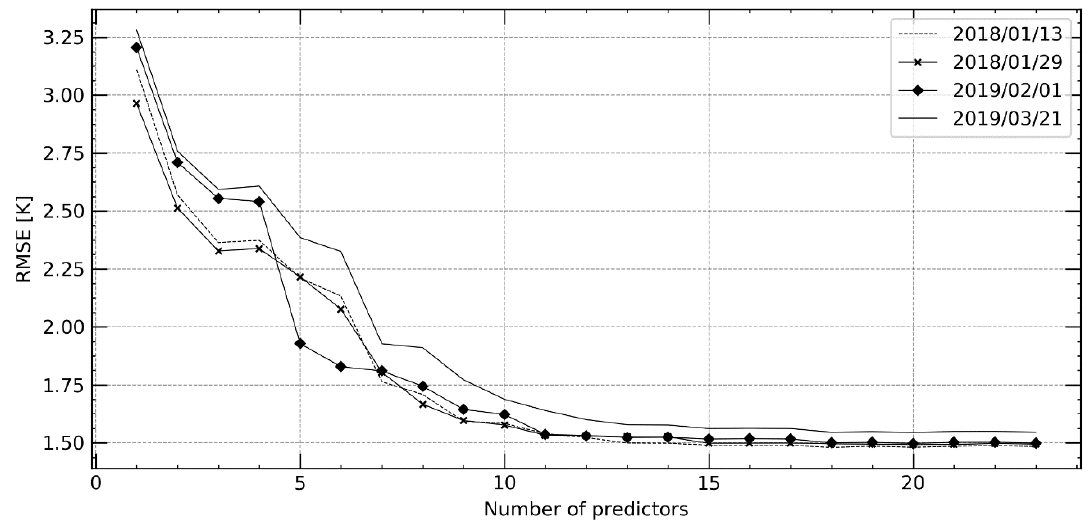
Figure 2. Variation of the root mean squared error (RMSE) obtained through recursive feature elimination with cross-validation (RFECV) with an increasing number of predictors.